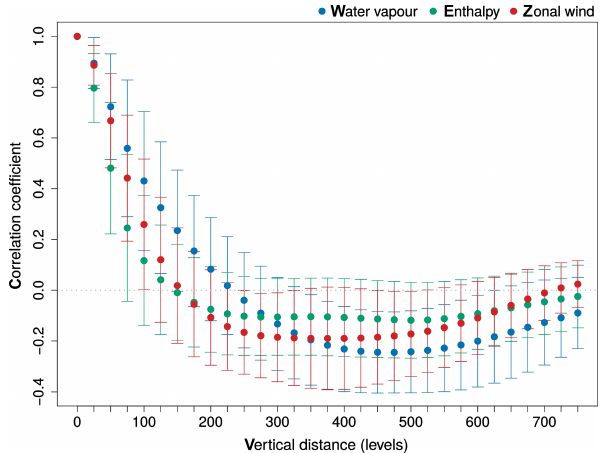
Figure 7. The vertical autocorrelation coefficients as a function of the vertical distance (in hPa) of the transport flux error for water vapour (blue), enthalpy (green) and zonal wind (red). The error bars show 1 standard deviation.